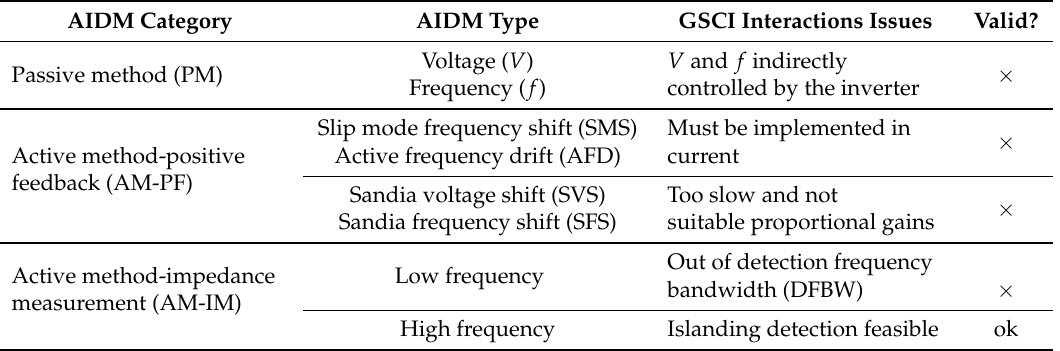
Table 3. Anti-islanding detection method (AIDM) versus grid support and constitution inverter (GSCI)